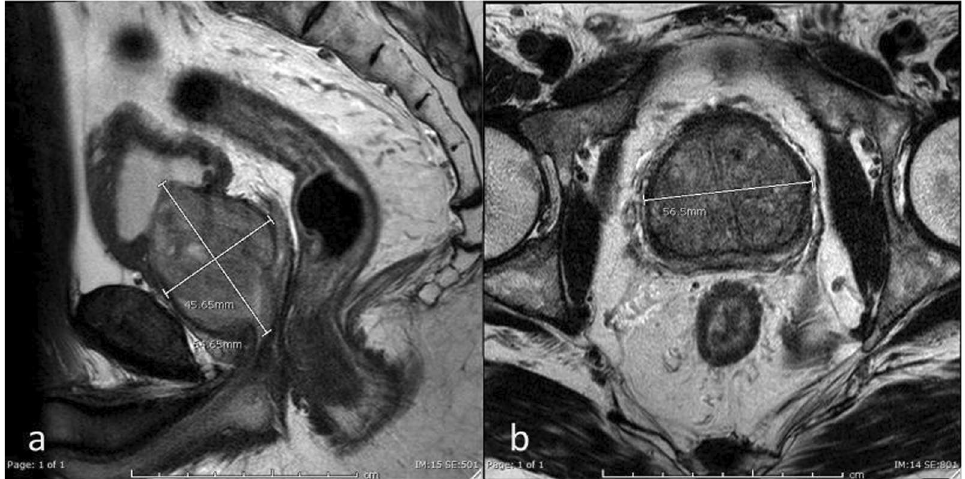
Fig. 1 Measurement of prostate gland size in three dimensions. a Mid-sagittal image using for measurement of length and height. b Axial T2W using for measurement of